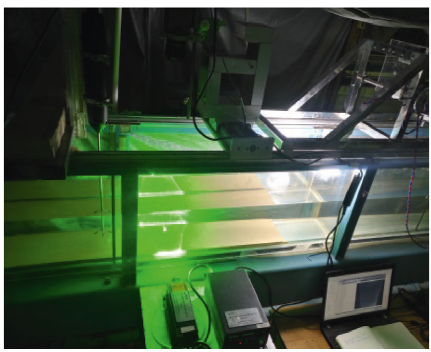
Figure 2: Gray image acquisition of sediment incipient